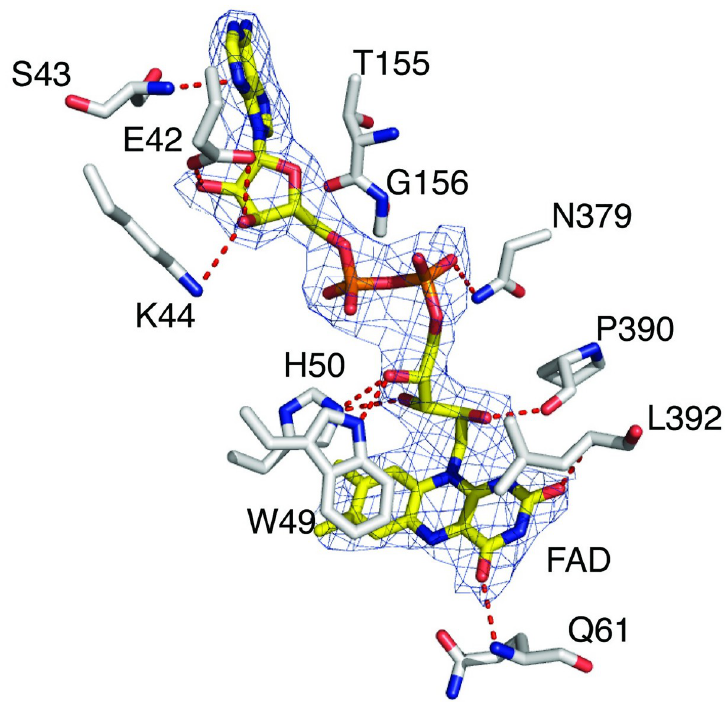
Fig 8. Active site environment of Ss DesB holoenzyme. View of the active site residues (carbon atoms in gray, nitrogen atoms in blue, and oxygen atoms in red) mediating FAD (carbon atoms in yellow, and phosphate atoms in orange) binding in the FAD-bound Ss DesB structure (PDB code: 6XBC). The fit of the FAD molecule to the final 2 F F c electron density map (blue mesh, 2.86 Å resolution, contoured at 1 σ level) is shown. https://doi.org/10.1371/journal.pone.0248385.g008 O2D ribose oxygen atom. The phosphate moiety of NADP + is held in place by a salt bridge O1X oxygen atoms. In addition, there is a hydrogen bond between the O3X oxygen and the side chain of S224.